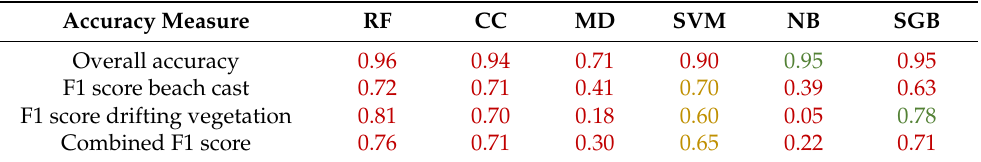
Table 2. Classification accuracies (overall accuracy, F1 scores, Combined F1 score) for the six classifiers with the band/index combination ‘B4’,‘B8’,‘B11’,‘FAI’,‘NDVI’ for S-2 (green = higher than Table 1, yellow = equal to Table 2, red = lower than Table